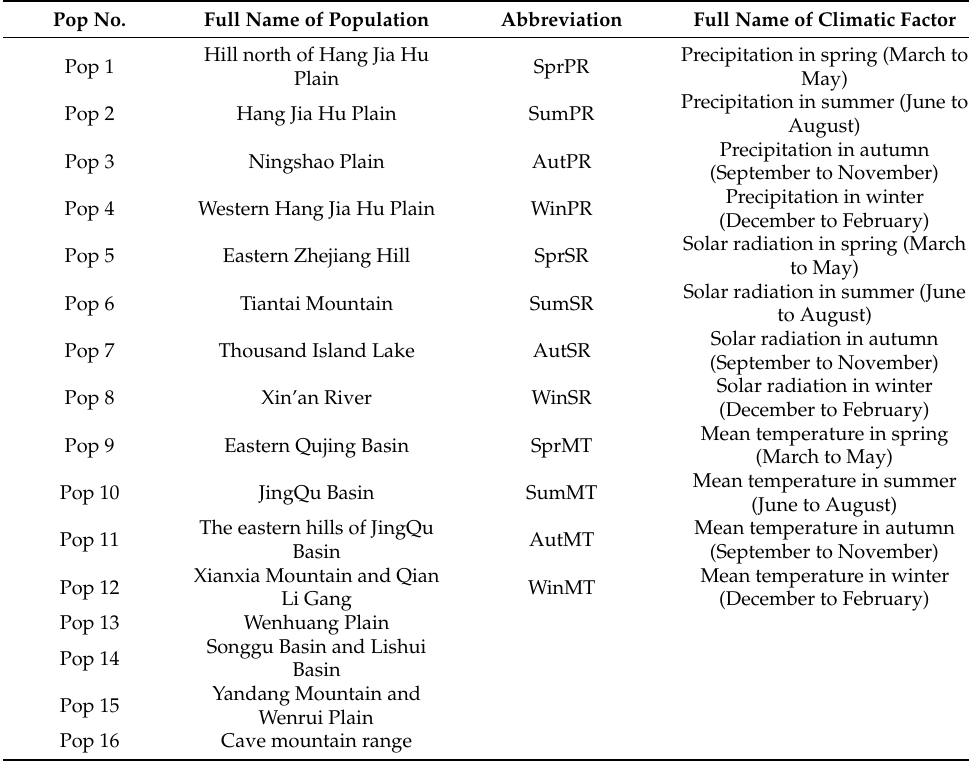
Table 1. Abbreviation and full name of population and climatic factor in this